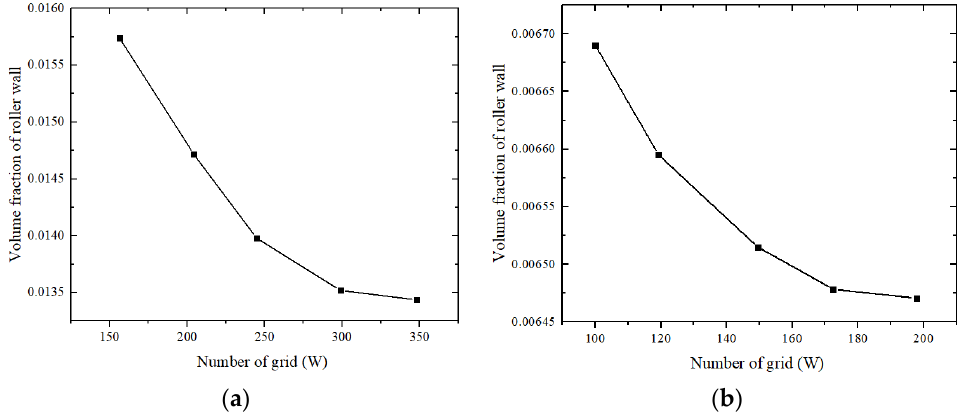
Figure 8. Meshing for the bearings of two different structures. ( a ) Outer ring rib structure; ( b ) Inner ring rib structure.